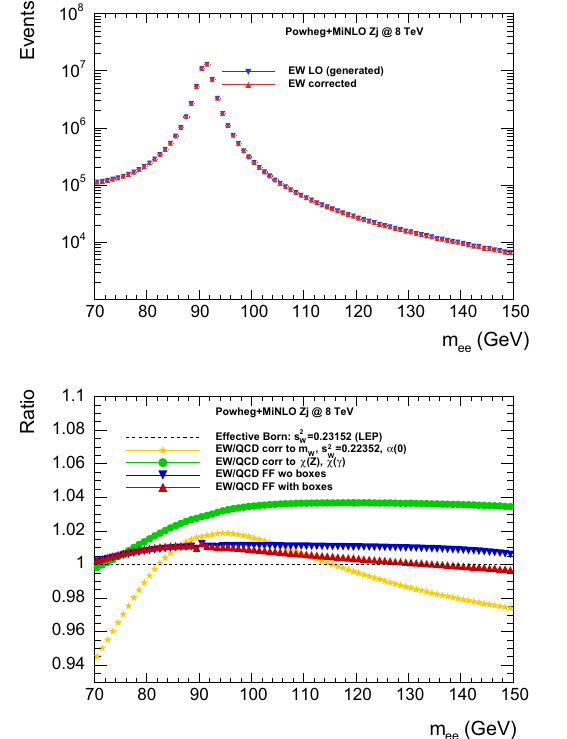
Fig. 4 Top-left: line-shape distribution as generated with Powheg+MiNLO (blue triangles) and after reweighting introduc- ing all EW corrections (red triangles). The two choices are barely distinguishable. Ratios of the line-shapes with gradually introduced to the one of effective Born (LEP with improved norm.) .